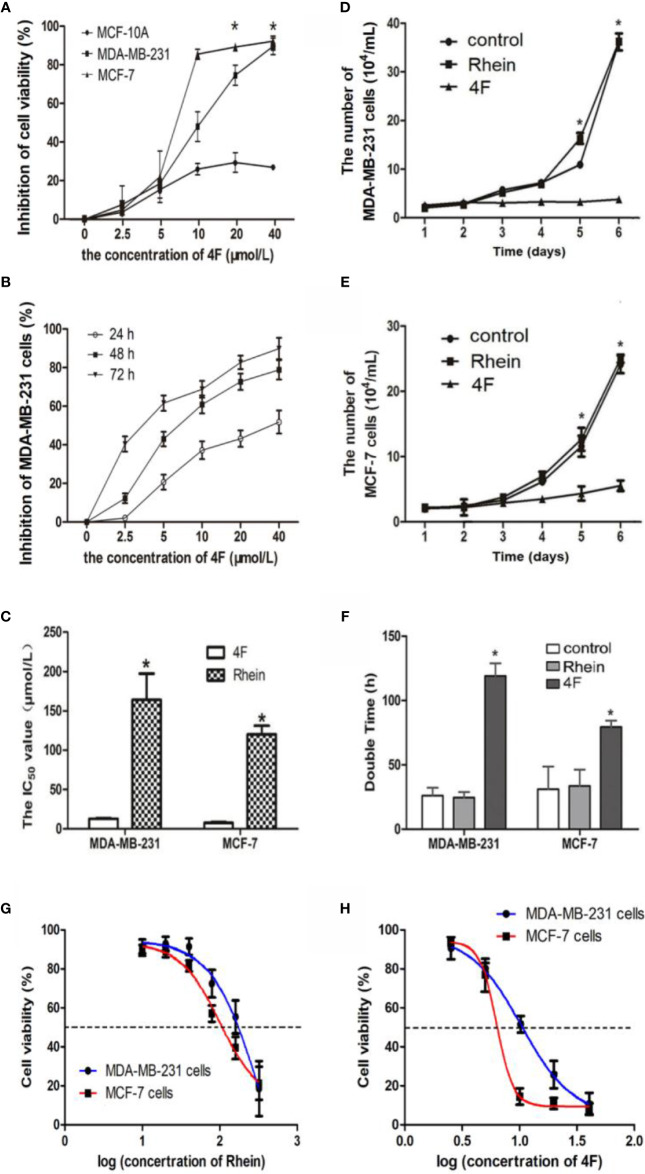
Derivative 4F inhibition of breast cancer or normal cell proliferation. Control group corresponds to cells growing without any drug. Cell numbers were measured by cytometer. IC50 values were calculated after 48 h of treatment. Data are shown as means ± SD (n = 3), one-way analysis of variance (ANOVA) was used for statistical analysis. (A) Comparison of derivative 4F cytotoxicity to breast cancer and normal breast cells. *P < 0.05, comparison of MCF-10A group and MDA-MB-231 or MCF-7 group. (B) MDA-MB-231 cells treated with different concentrations of derivative 4F for 24, 48, and 72 h. (C) IC50 values of the two breast cancer cell lines. *P < 0.05, comparison of derivative 4F group and Rhein group. (D) Growth curve of MDA-MB-231 cells. *P < 0.05, comparison of derivative 4F group and control group. (E) Growth curve of MCF-7 cells. *P < 0.05, comparison of derivative 4F group and control group. (F) Doubling time of two breast cancer cell lines. *P < 0.05, comparison of derivative 4F group and control group. (G) IC50 curve of Rhein in MDA-MB-231 and MCF-7 cells. (H) IC50 curve of derivative 4F in MDA-MB-231 and MCF-7 cells.